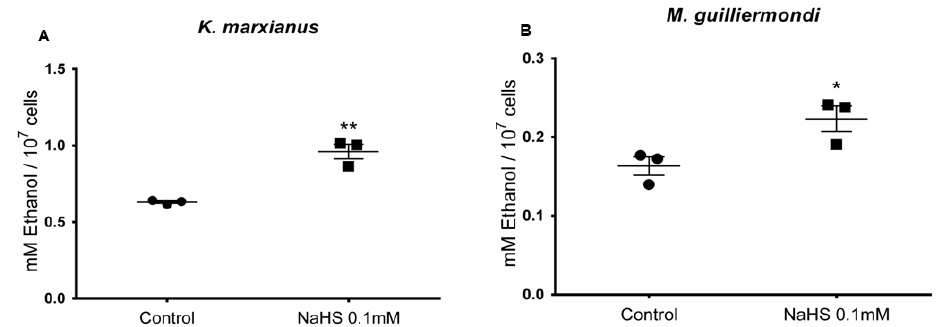
Figure 8. Exogenous H 2 S induces ethanol production in K. marxianus and M. guilliermondi . ( A ) K. marxianus yeast cell cultures were treated with NaHS 0.1 mM, and seven hour later, supernatants were collected. Ethanol production was measured in vitro at 37 °C. Unpaired t ** p = 0.002. ( B ) M. guilliermondi yeast cell cultures were treated with NaHS 0.1 mM, and 24 h later, cells were treated again with same concentration of NaHS. Seven hour later, supernatants were collected. Ethanol production was measured in vitro at 37 °C. Unpaired t * p = 0.04. Closed circles, untreated cells; closed squares, NaHS 0.1 mM.